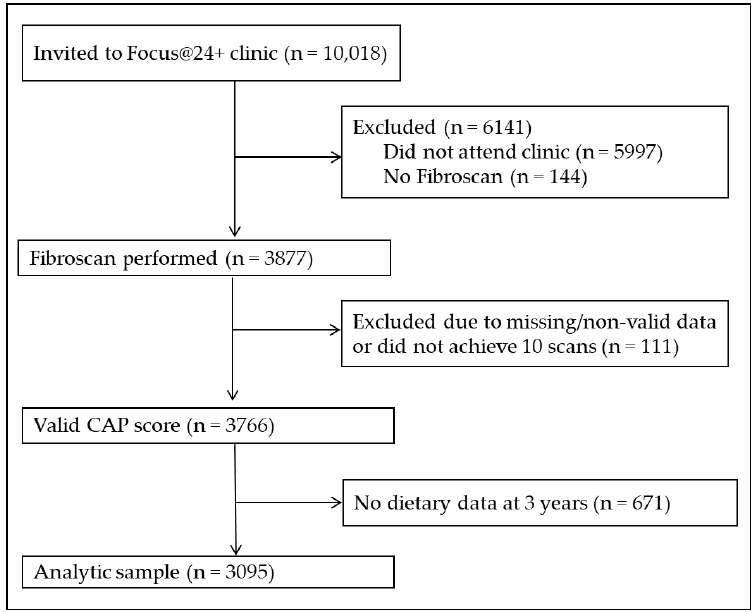
Figure 1. Participant flowchart for the analytic sample. Participants that did not attend the 24-year clinic or get a liver scan because they were ineligible due to an active implant, liver ascites, or pregnancy were excluded. Participants with missing or non-valid CAP scores or with missing dietary data from the three-year food frequency questionnaire were also excluded. Our final sample size was 3095.